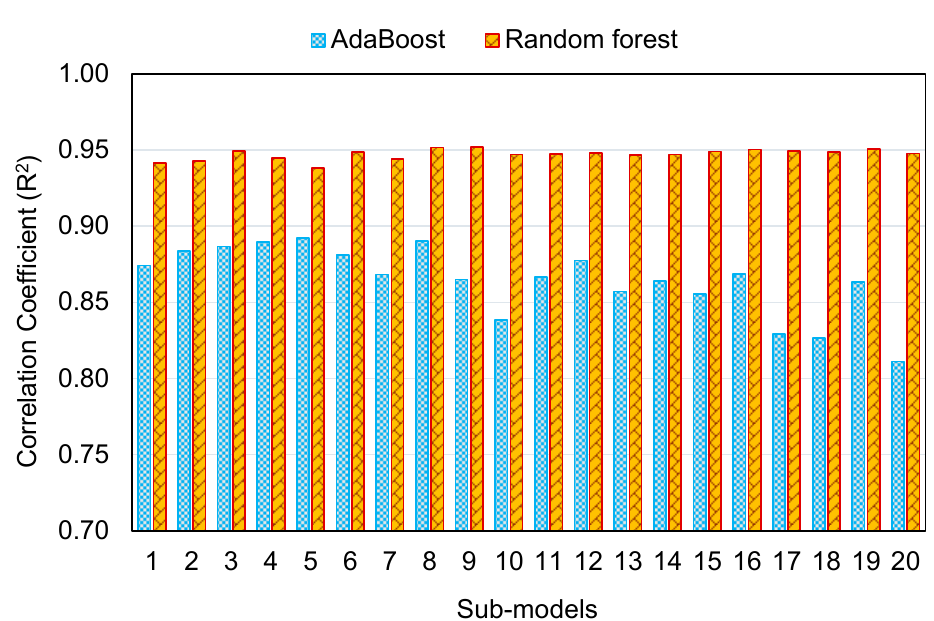
Figure 20. The correlation coefficient of ensemble machine learning sub-models.